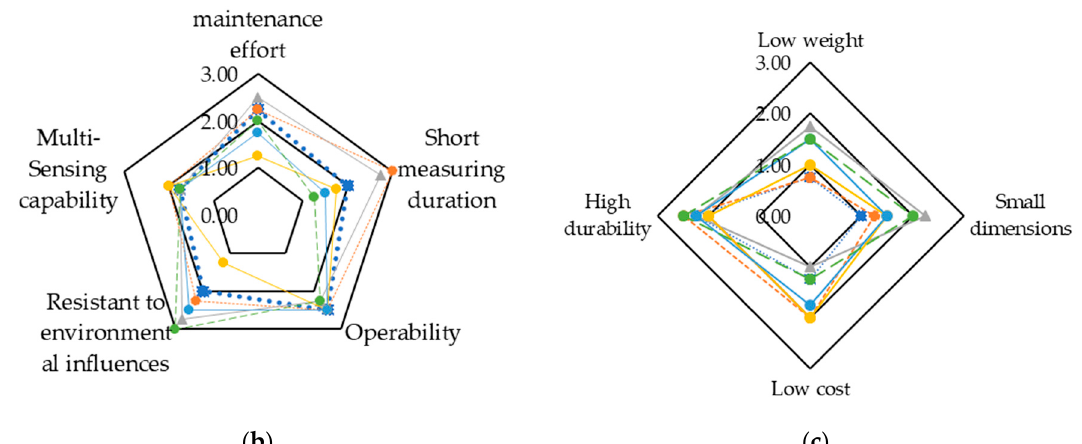
Figure 3. Evaluation of the requirement criteria on their importance for the categories of ( a ) measurement quality; ( b ) handling; ( c ) technical construction and production; 0 = not important, 1 = rather unimportant 2 = important, 3 = very important; sample size: